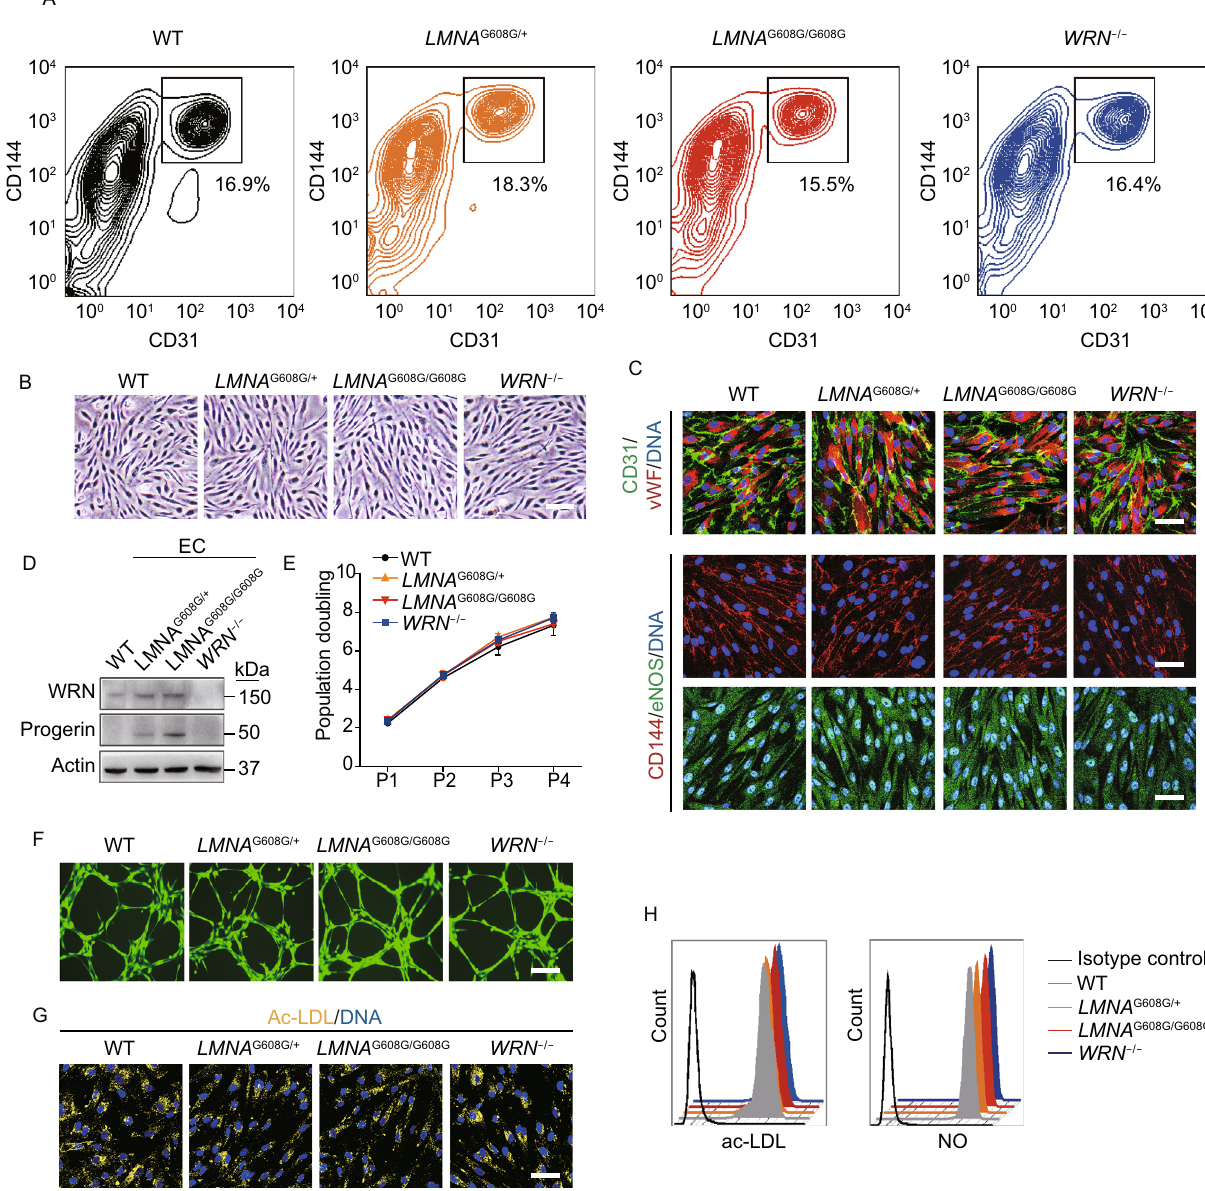
Figure 7. Acquisition and characterization of HGPS-ECs and WS-ECs. (A) CD31/CD144 positive cells were sorted as ECs by FACS. (B) Representative morphology of WT, heterozygous ( LMNA G608G/+ ), homozygous ( LMNA G608G/G608G ) and WRN − / − ECs. Scale bar, 50 μ m. (C) Immunostaining of EC-speci fi c markers (CD31/vWF/CD144/eNOS) in WT, heterozygous ( LMNA G608G/+ ), homozygous ( LMNA G608G/G608G ) and WRN − / − ECs. Scale bar, 50 μ m. (D) Western blot analysis of WRN and progerin expression in WT, heterozygous ( LMNA G608G/+ ), homozygous ( LMNA G608G/G608G ) and WRN − / − ECs. Actin was used as loading control. (E) Growth curve analysis showing the population doubling of ECs, n = 3. (F) The abilities of in vitro tube formation in WT, heterozygous ( LMNA G608G/+ ), homozygous ( LMNA G608G/G608G ) and WRN − / − ECs. Cells were stained by Calcein-AM. (G) The uptake abilities of Dil- Ac-LDL in WT, heterozygous ( LMNA G608G/+ ), homozygous ( LMNA G608G/G608G ) and WRN − / − ECs. Scale bar, 50 μ m.(H) Measurement of Dil-Ac-LDL and nitric oxide (NO) by FACS in WT, heterozygous ( LMNA G608G/+ ), homozygous ( LMNA G608G/G608G ) and WRN − / −